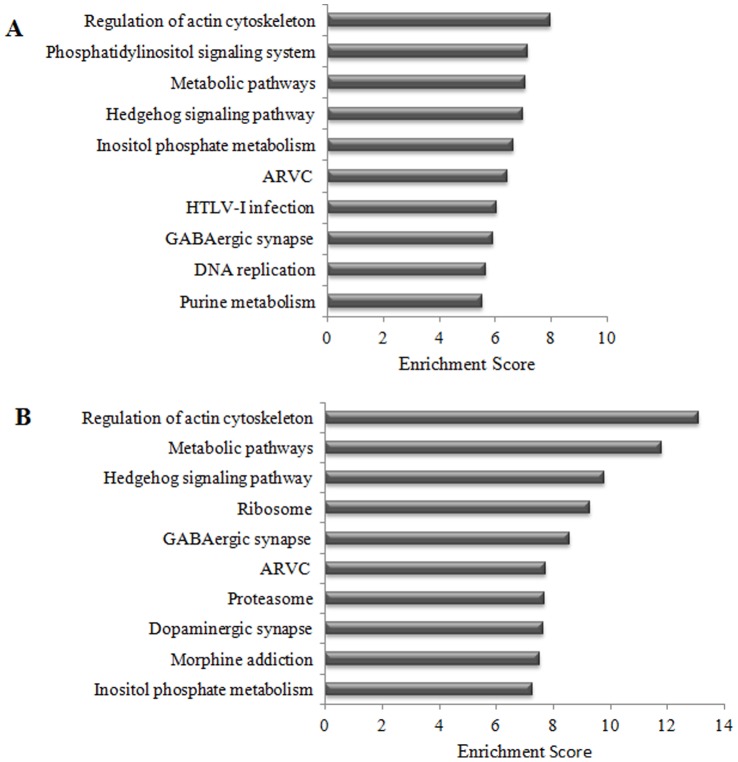
Pathway analysis of miRNAs that were regulated in early time points and late time points after MCAo.Top ten pathways with minimum Enrichment Score of 5.5 were selected. (A) Top ten pathways for miRNAs in earlier time points of MCAo model; (B) Top ten pathways for miRNAs in later time points of MCAo. ARVC- Arrhythmogenic right ventricular cardiomyopathy.